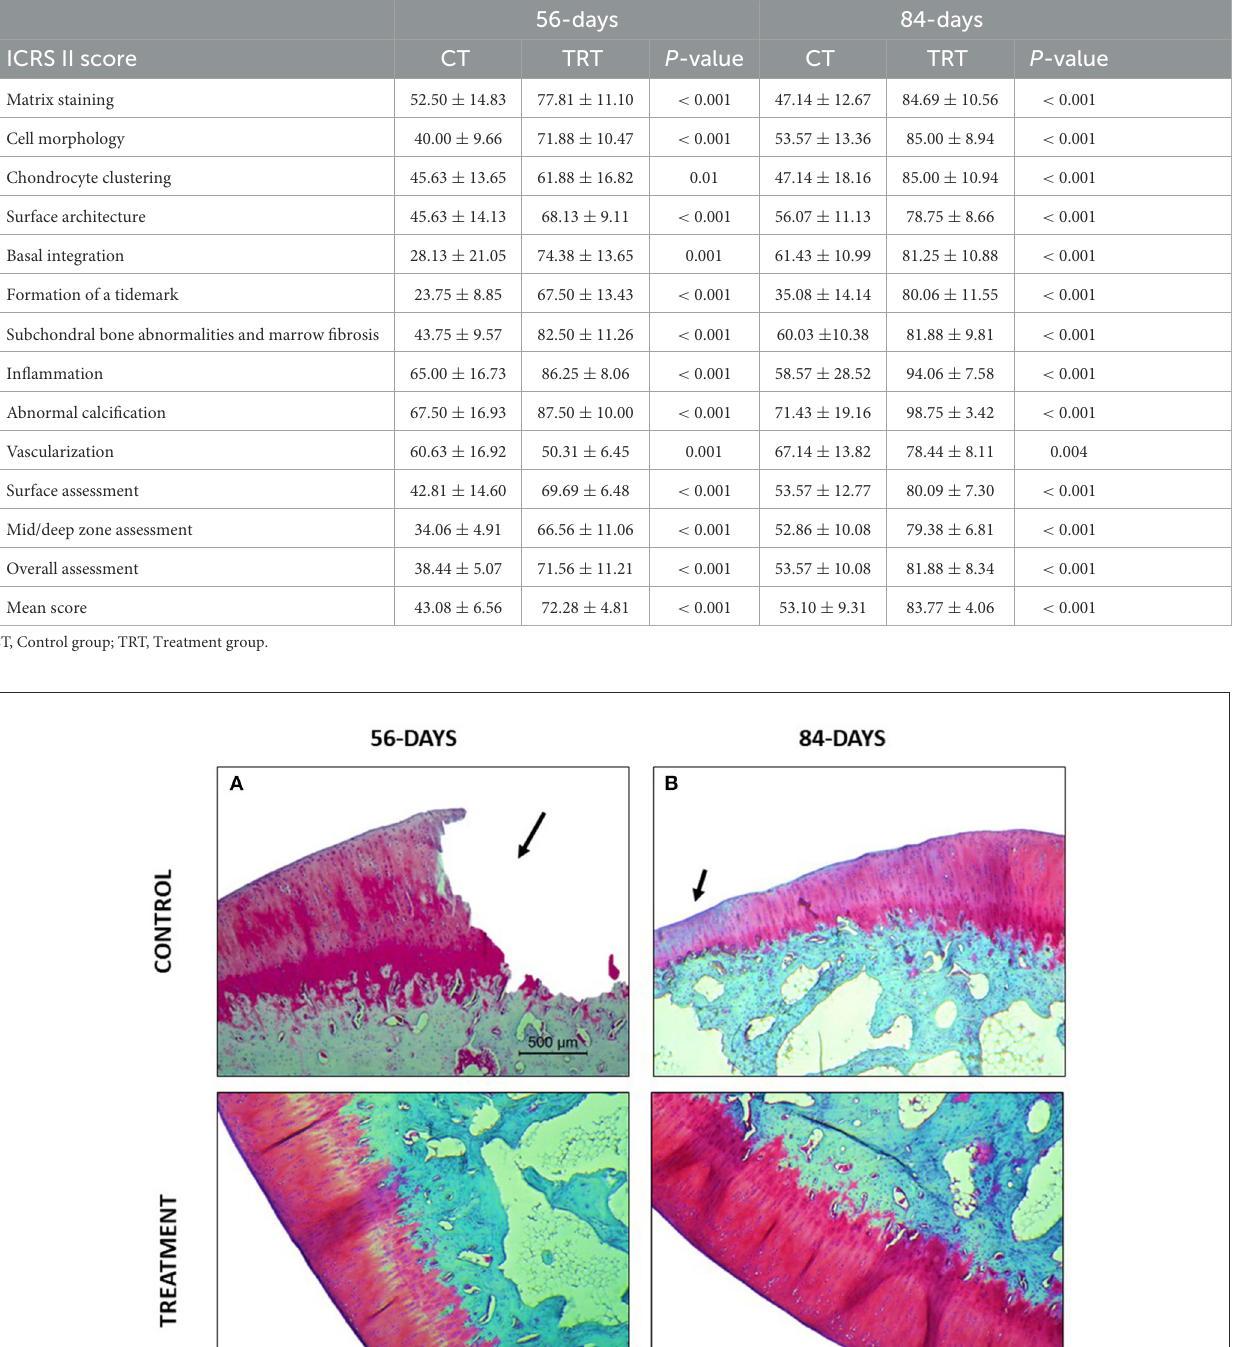
TABLE 4 ICRS II score mean and standard deviation at 56 and 84 days follow-up.